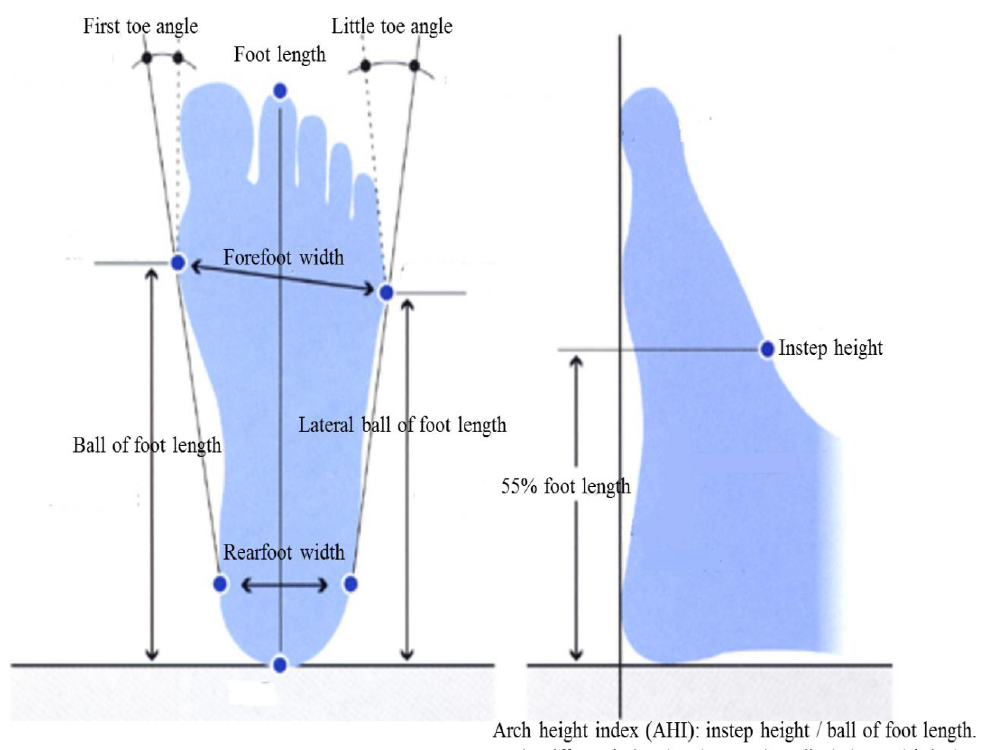
Fig. 1. The descriptions of major indicators of foot structure. Table 2. Differences of right foot structure in bipedal standing position among different BMI groups by one-way ANOVA test followed by Bonferroni-Dunn post-hoc test. Variables Non-obese men Overweight men Obese men p values Foot length (mm) 254.07 ±